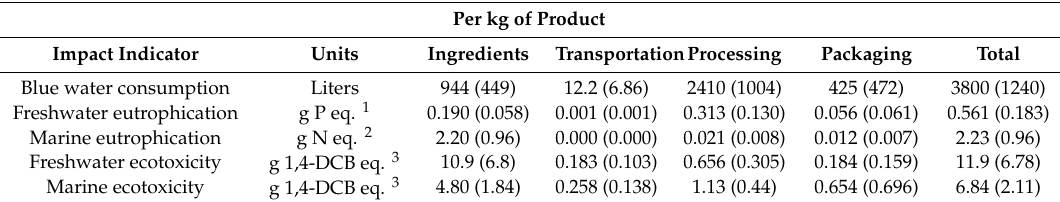
Table 1. Mean (standard deviation) of water-related impacts attributable to di ff erent phases of meat analog production. Data for impact categories are reported per kg of final